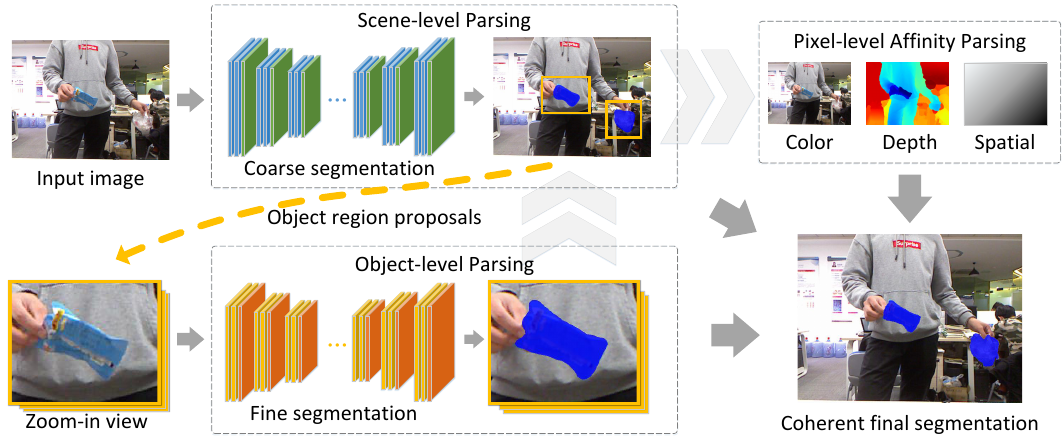
Figure 2. Overview of the proposed method. Given an input image, we approach the waste object segmentation problem at three levels: (i) scene-level parsing for an initial coarse segmentation, (ii) object-level parsing to recover fine details for each object region proposal, and (iii) pixel-level refinement based on color, depth, and spatial affinities. Together, joint inference at all these levels produces coherent final segmentation